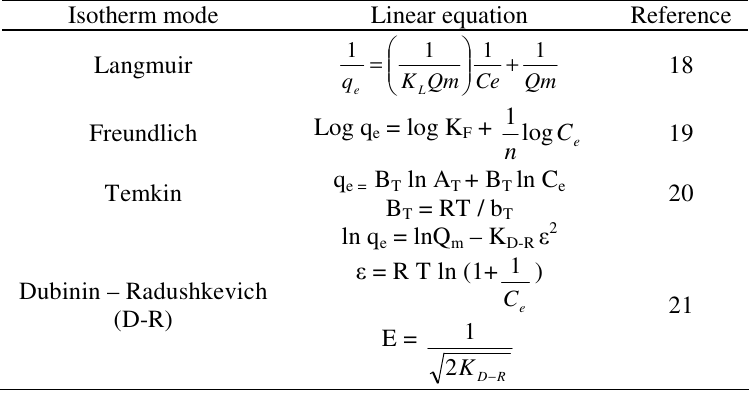
Table 1 . The linear equations of isotherm